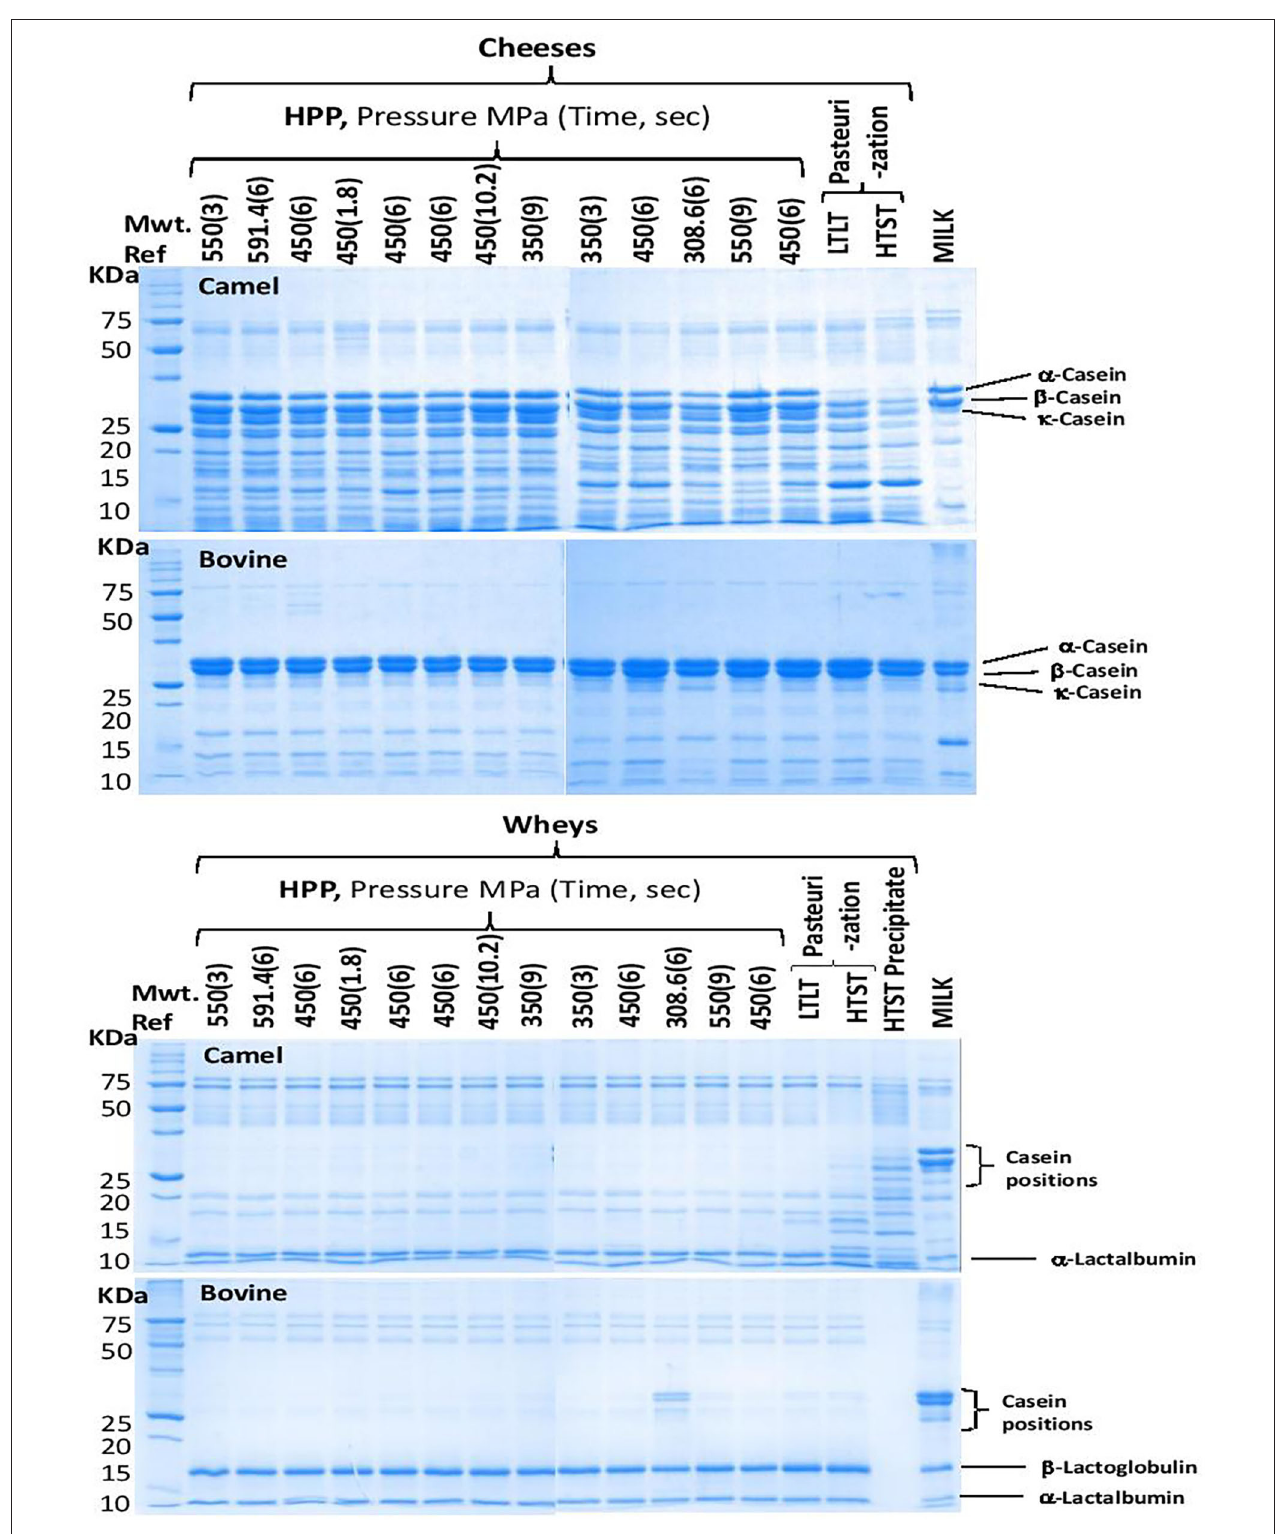
FIGURE 5 | SDS-PAGE electropherograms of the camel and bovine cheeses and whey. For processing conditions (see Table 1 ).